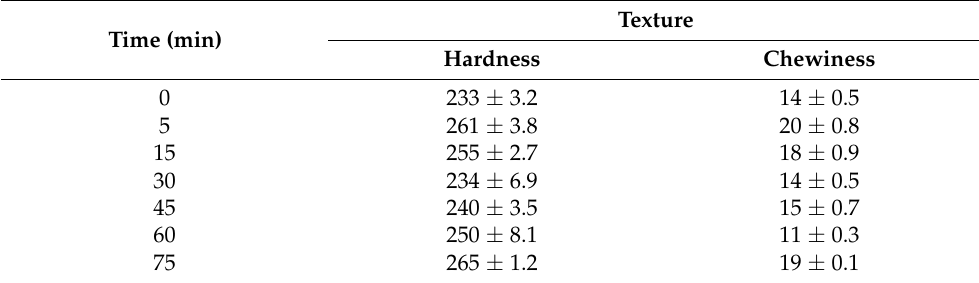
Table 7. Texture of sea squirt by FE-DBD plasma